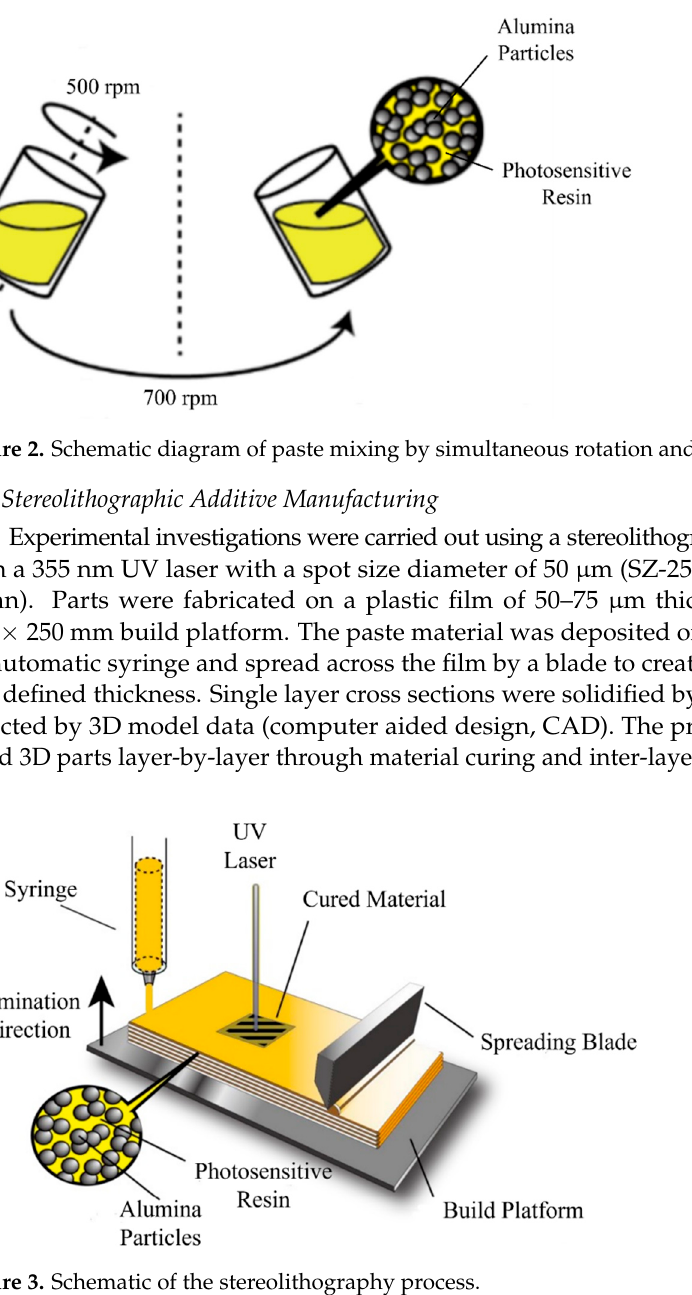
Figure 3. Schematic of the stereolithography process.